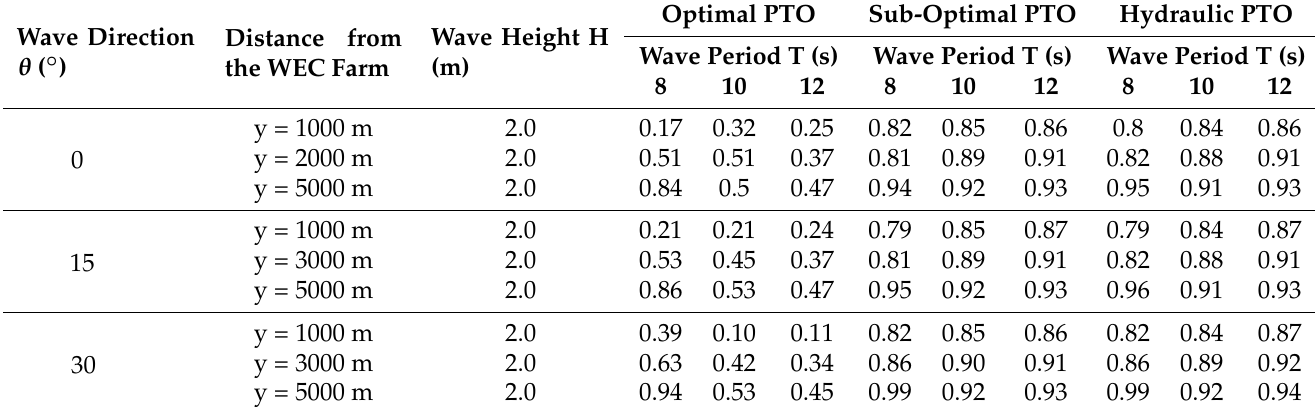
Table 5. K d disturbance coefficient for a farm of 21 HPA WECs for a linear optimal, a linear sub-optimal and a hydraulic